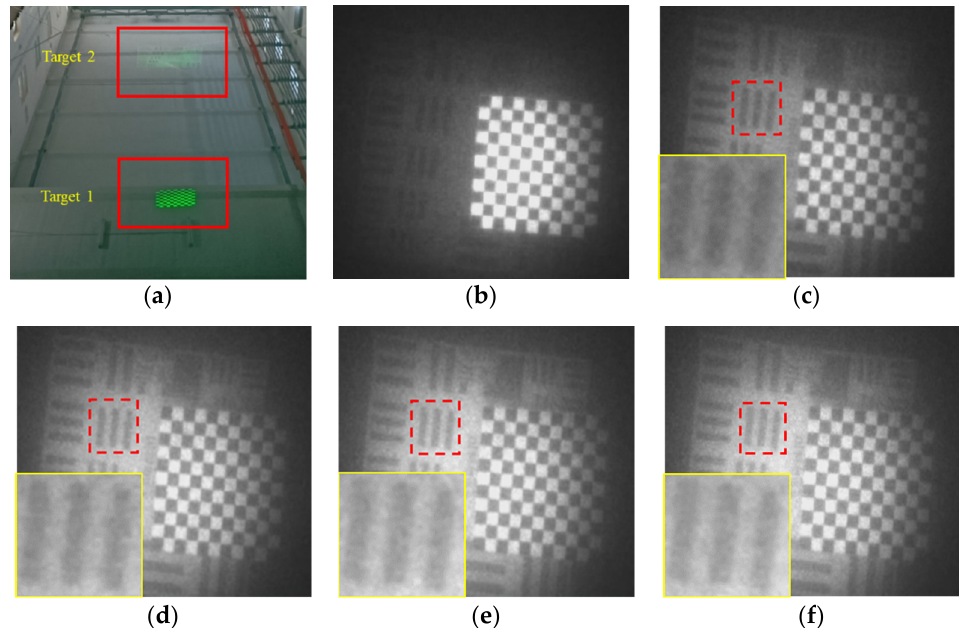
Figure 9. Performance of single slice and multi-slice. ( a ) Two targets in experiment; ( b ) Output of single slice; ( c ) Output of multi-slice, whose GW is 25 ns; ( d ) Output of multi-slice, whose GW is 43.75 ns; ( e ) Output of multi-slice, whose GW is 50 ns; ( f ) Output of multi-slice, whose GW is 55 ns.